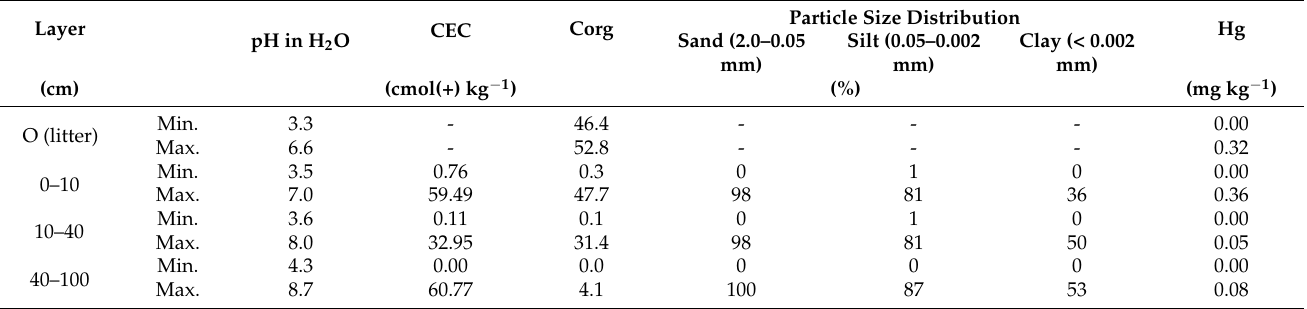
Table 3. Selected soil properties on research plots